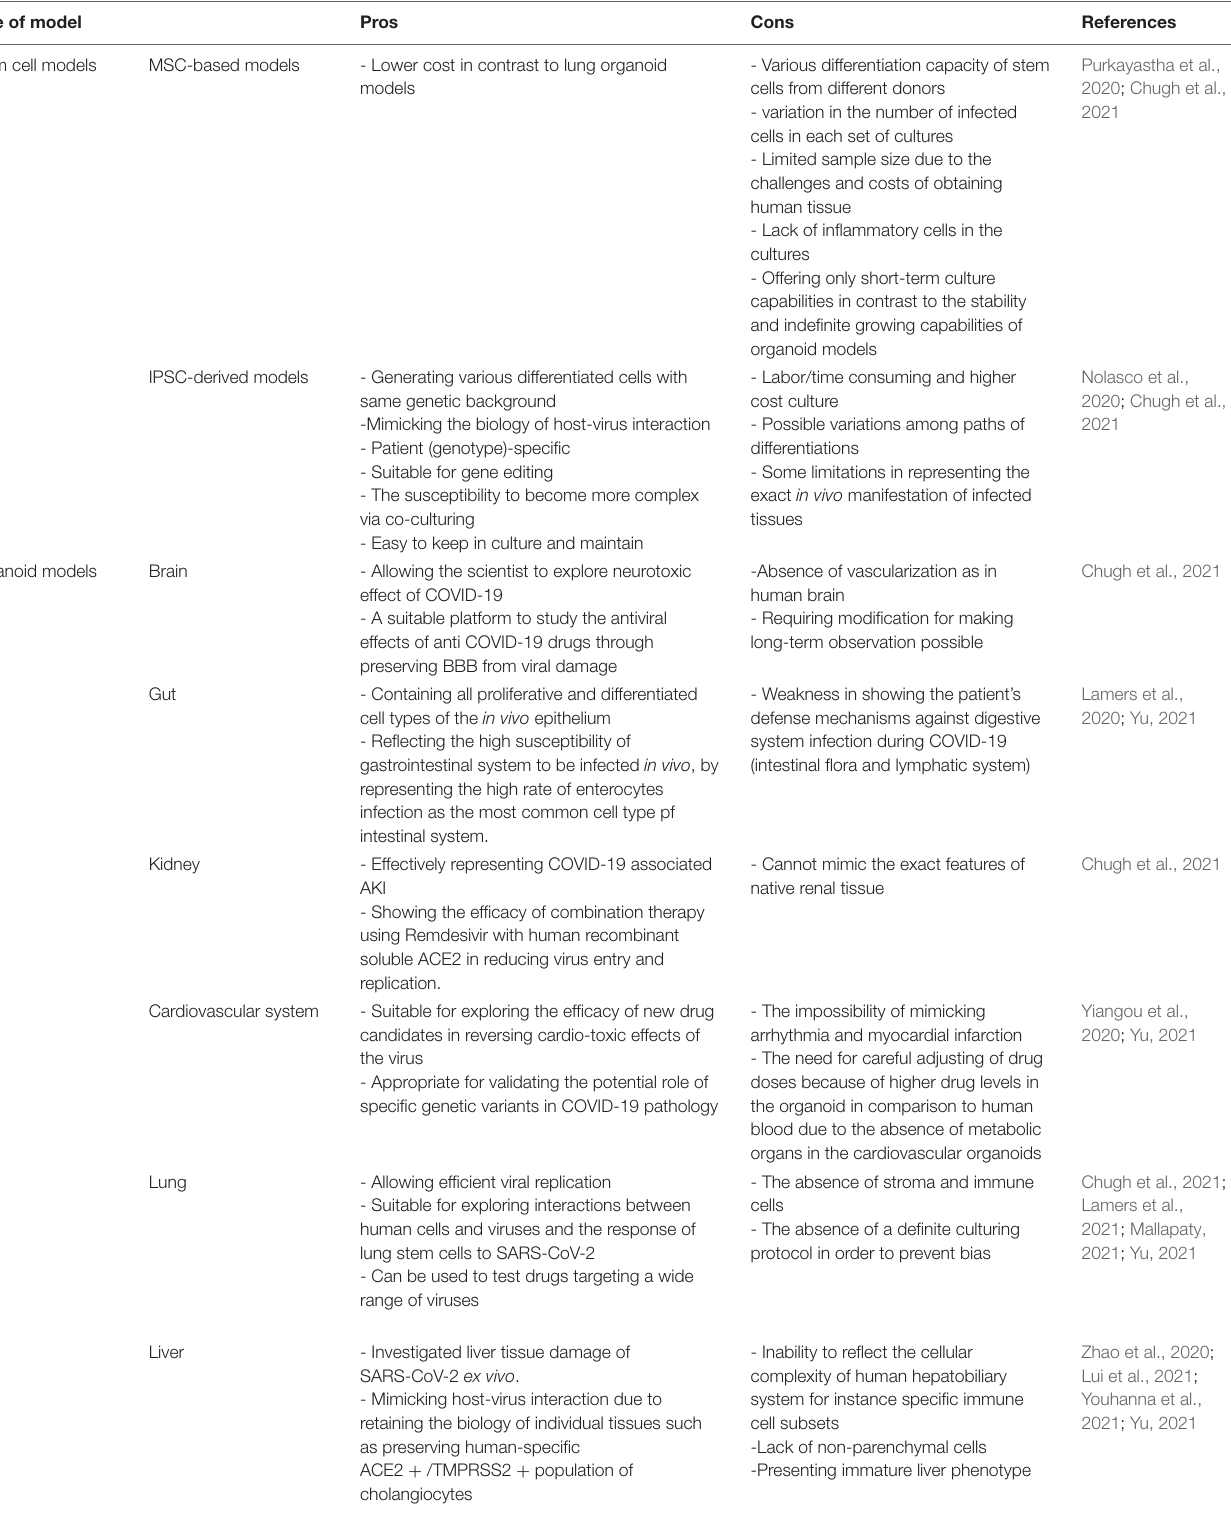
TABLE 1 | Pros and cons of stem cell and organoid models of Severe Acute Respiratory Syndrome Coronavirus-2